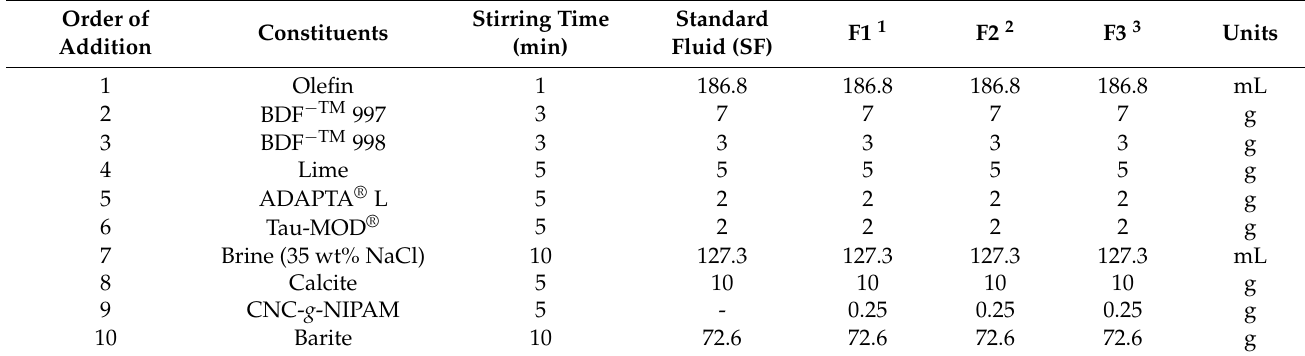
Table 4. Compositions of the drilling